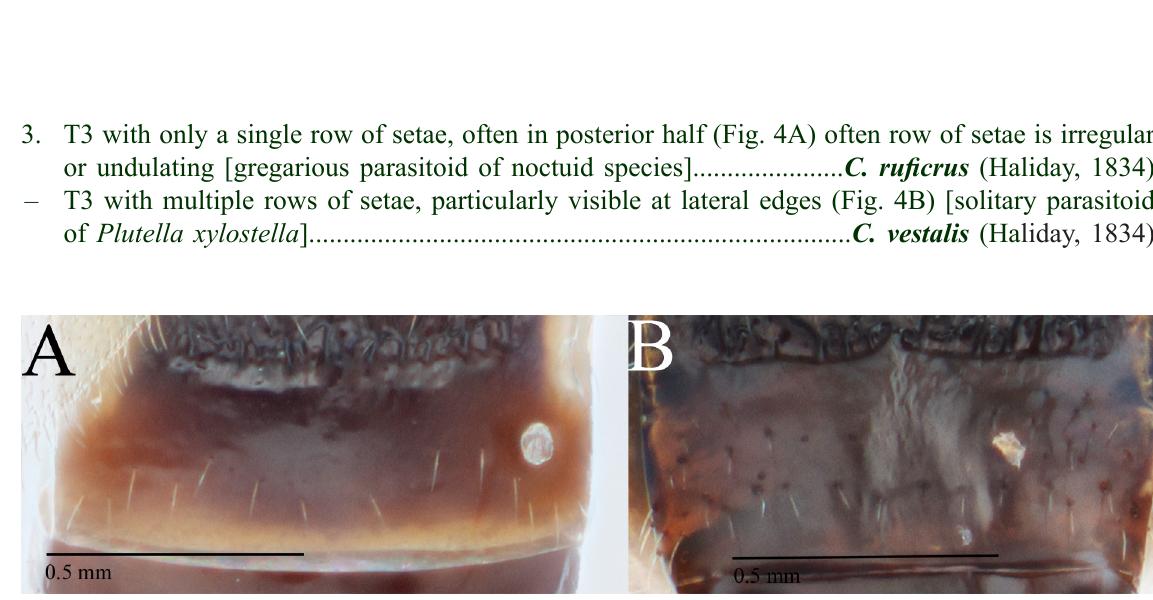
Fig. 3. A . Cotesia ruficrus (Haliday, 1834), scutellar disk (ANIC 32 130230). B . C. rufiventris (Bingham, 1906), scutellar disk (paralectotype NHMUK).